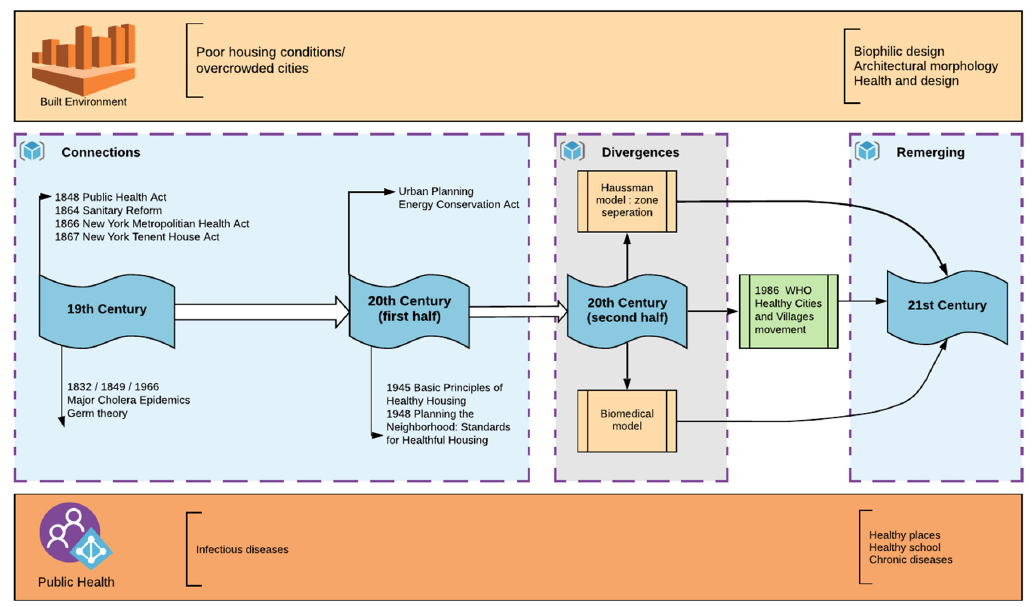
Figure 1. Connections, divergences, and remerging between public health and the built environment.